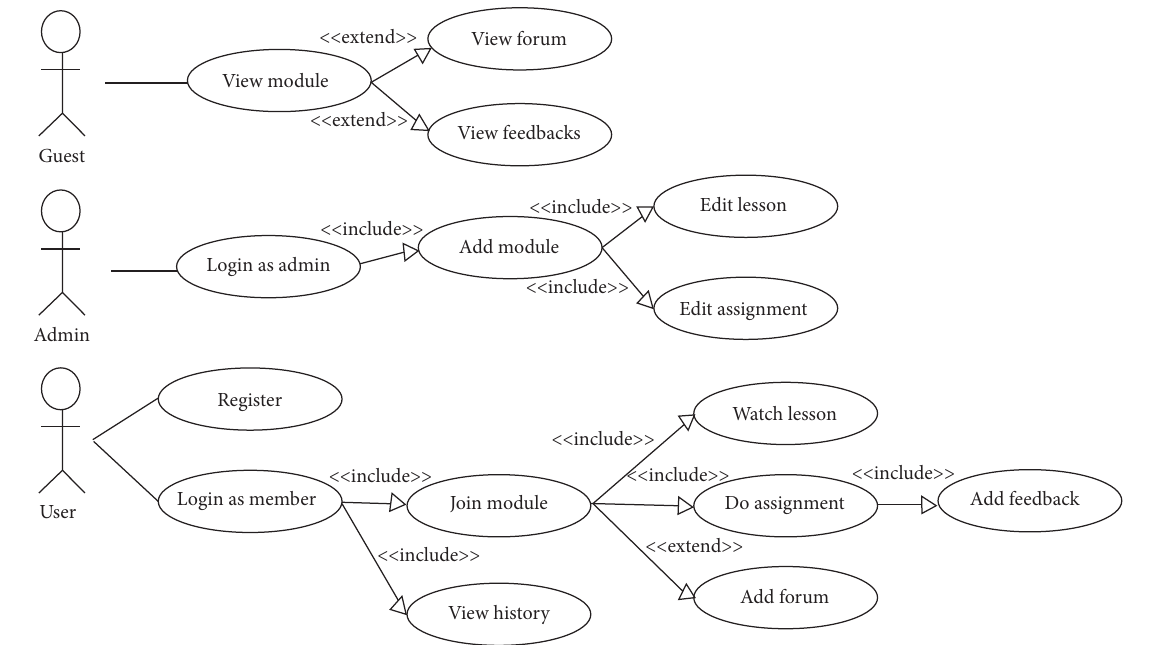
Figure 1: Use case diagram of the proposed model